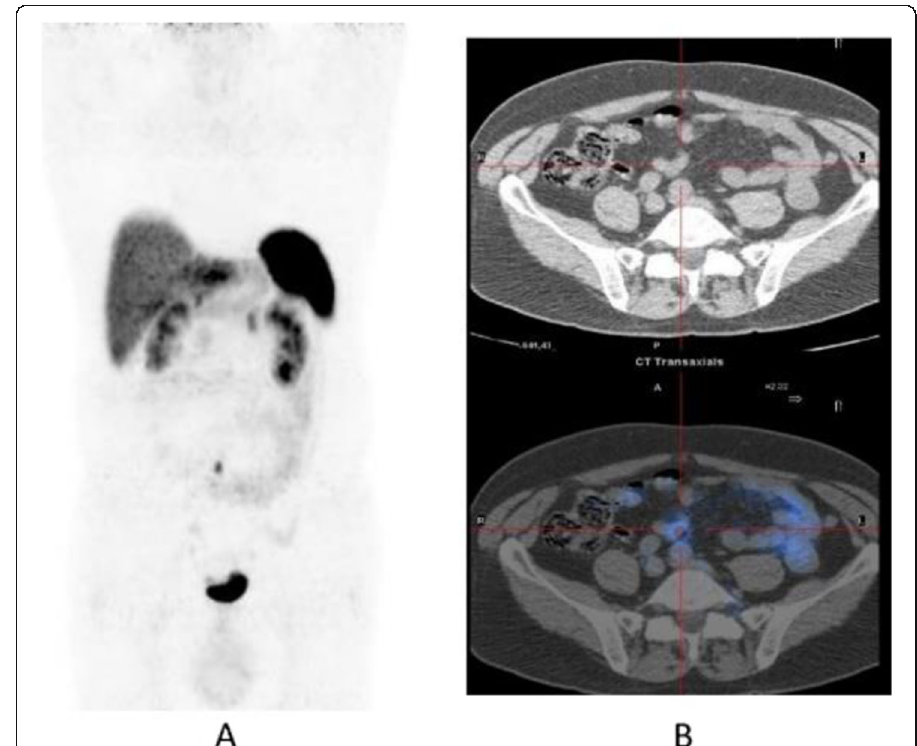
Fig. 50 68Ga-DOTA peptide, suspected lesion of the liver, specificity. Clinical history : 52 y.o. male with an incidental detection of a single liver lesion in the left lobe. The lesion is suspect to be a metastasis on ultrasound and CT from an unknown primary site. PET/CT findings : increased focal uptake in a loop of the ileum, suspect to be a primary tumour. Increased uptake in the left liver lobe consistent with a secondary lesion ( a MIP, b CT and fused images). After surgery, the lesions were diagnosed to be a well-differentiated